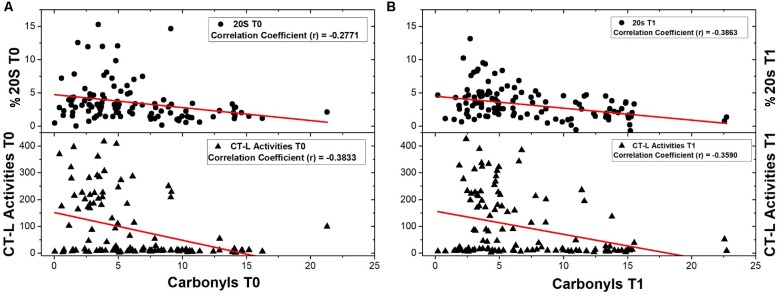
Correlations of 20S content and CT-L activity with protein carbonyls’ levels were examined before and after the intervention as well. (A) 20S content and CT-L activity were correlated with protein carbonyls’ levels before any intervention (number of samples: 108 and 119 respectively). (B) Analysis of correlations of 20S content and CT-L activity with protein carbonyls’ levels was also performed after the intervention (number of samples: 114 and 115 respectively).